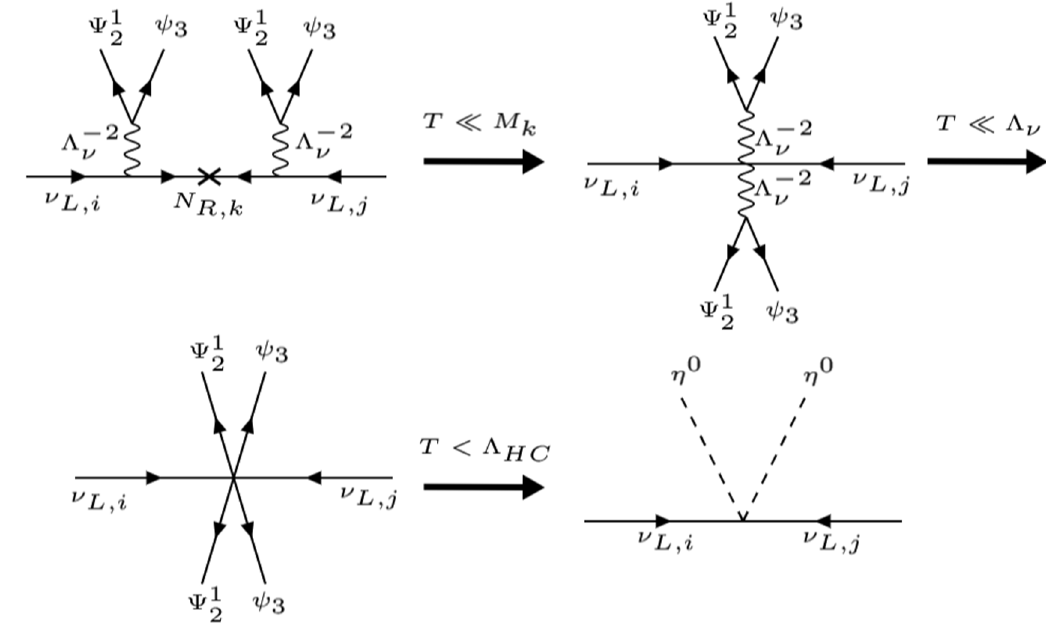
Figure 8 . Development of the ( η 0 ) 2 ( ν L ) 2 four-vertices for the ETC-type approach when M i (cid:29) Λ ν from temperatures above M k down to zero-temperature by integrating out the propagators of the right-handed neutrinos, N R,k , and the ETC gauge or scalar boson(s) with masses in order of Λ ν . In this process, M k (cid:29) Λ ν (cid:29) Λ HC